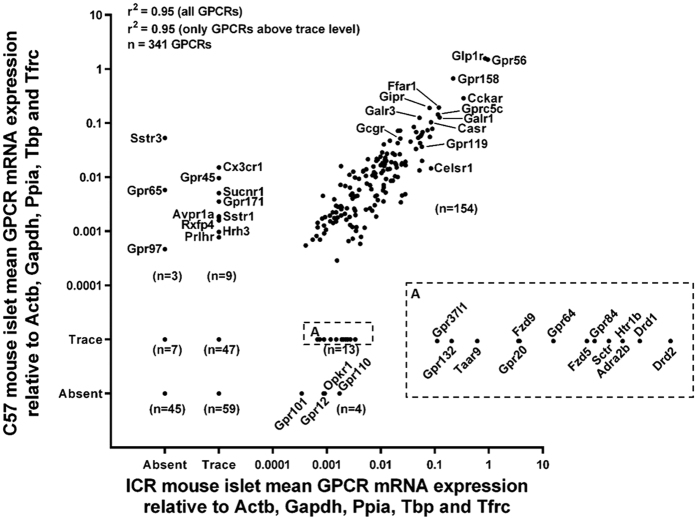
Comparison of the relative expression of 341 GPCR mRNAs in islets isolated from the outbred ICR and inbred C57 mouse strains.Insert panel A has been enlarged to allow visualisation of GPCRs expressed above trace level only in ICR mouse islets. Data are presented as mean GPCR expression relative to the reference genes Actb, Gapdh, Ppia, Tbp and Tfrc from non-pooled biological replicates from four C57 and four ICR mice.